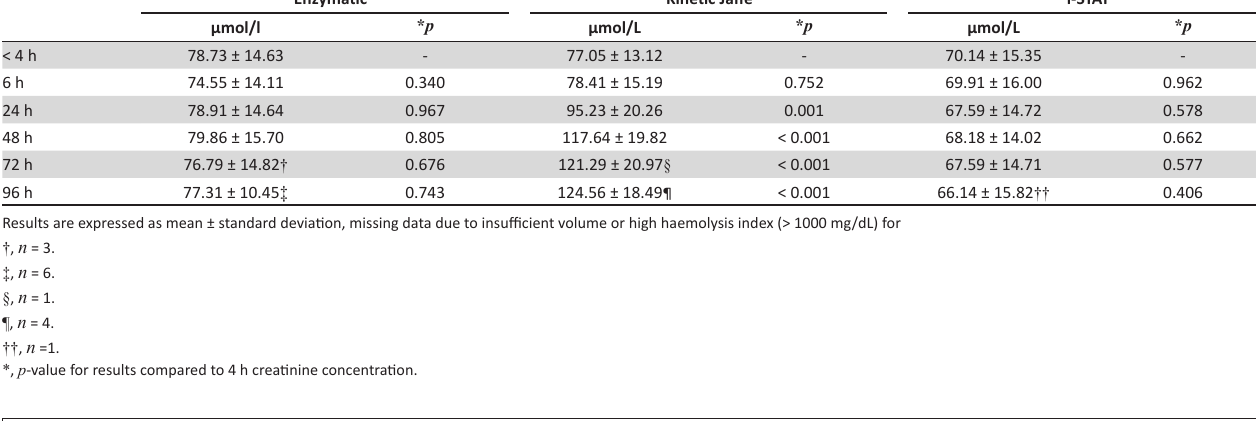
051015202530354045